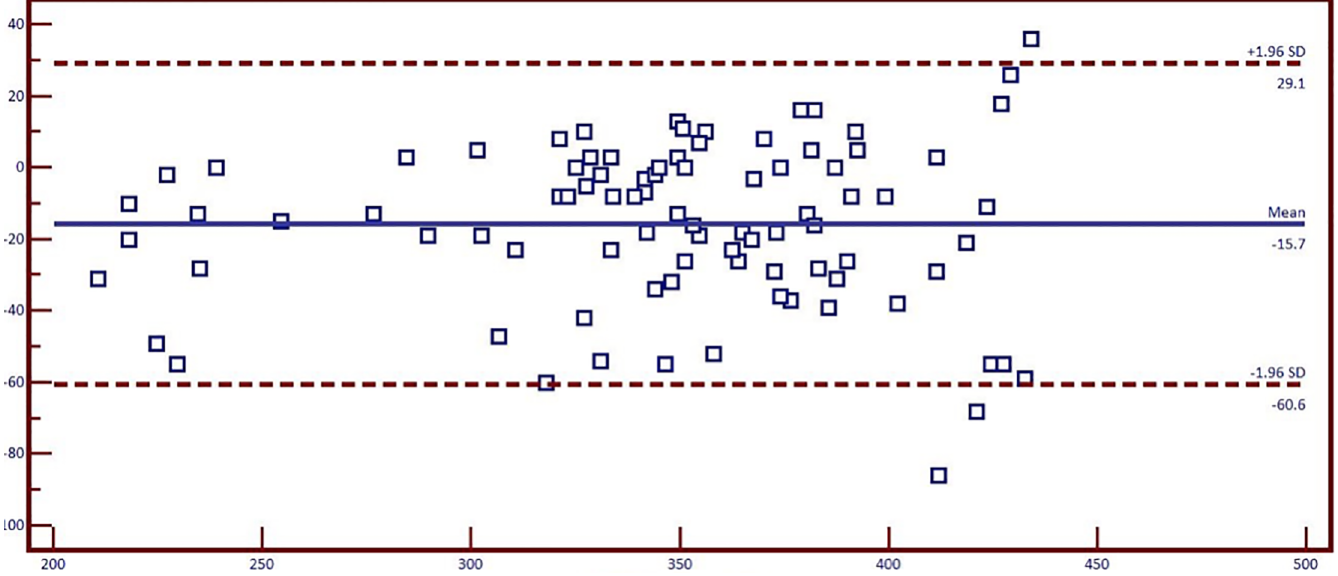
Fig 8. Bald-Altman plot showing inter-observer variability between two observers.